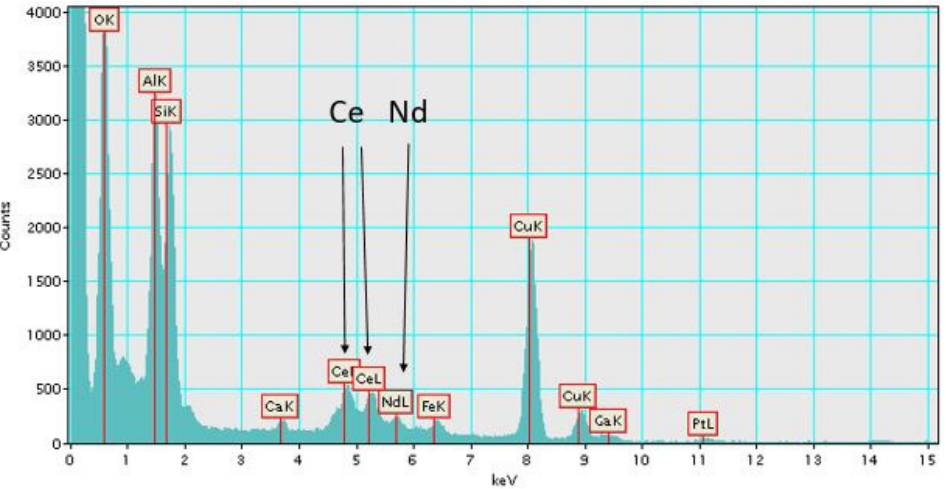
Figure 7. EDS scan of Figure 6 crystal showing the presence of Ce and Nd.